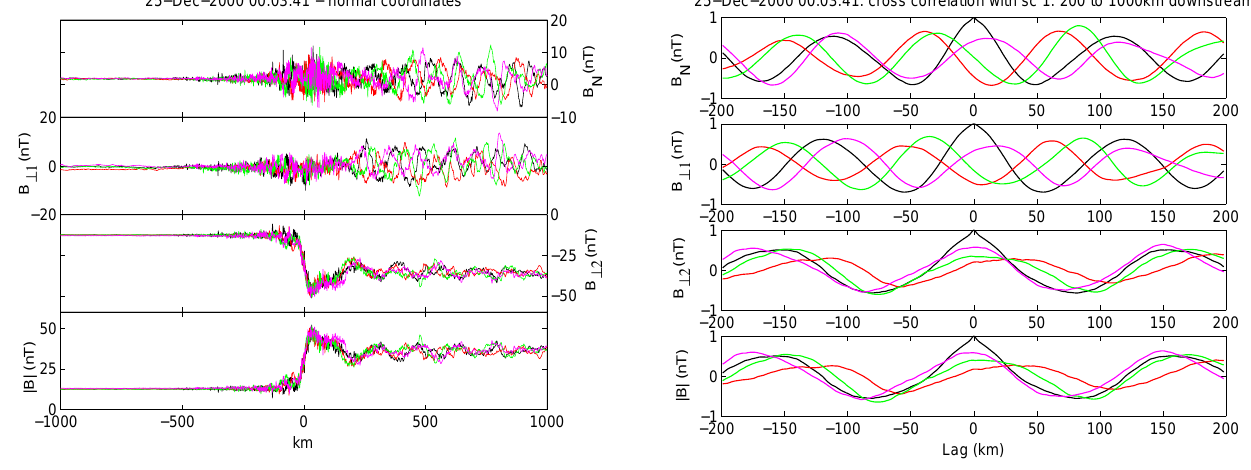
Fig. 5. Cross correlations between spacecraft for data between 200 and 1000km downstream of the 00:03 shock. Data for each space- craft are cross correlated with those from spacecraft 1 for each field coordinate in the same system as Fig. 4. Colours are black, red, green and magenta for spacecraft 1, 2, 3 and 4,